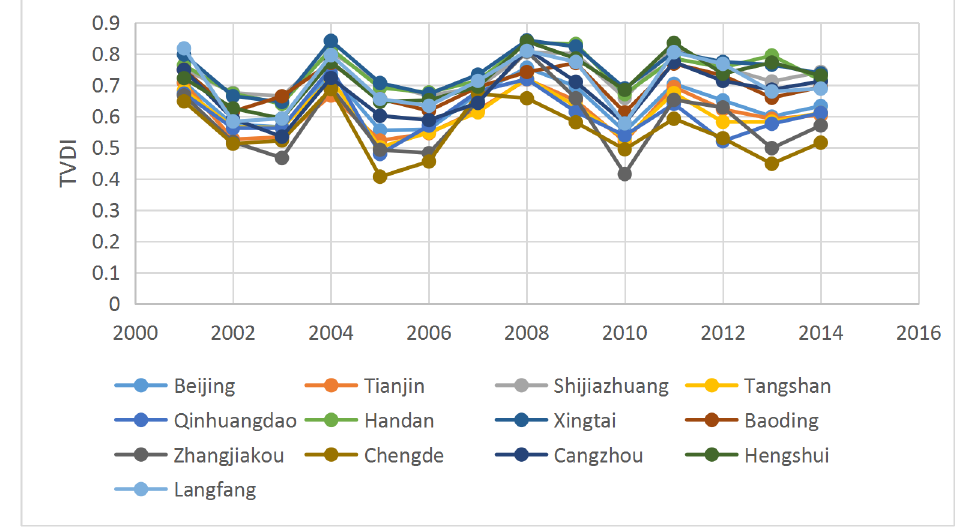
Figure 3. Changes in TVDI values from 2001 to 2014 in Beijing, Tianjin and